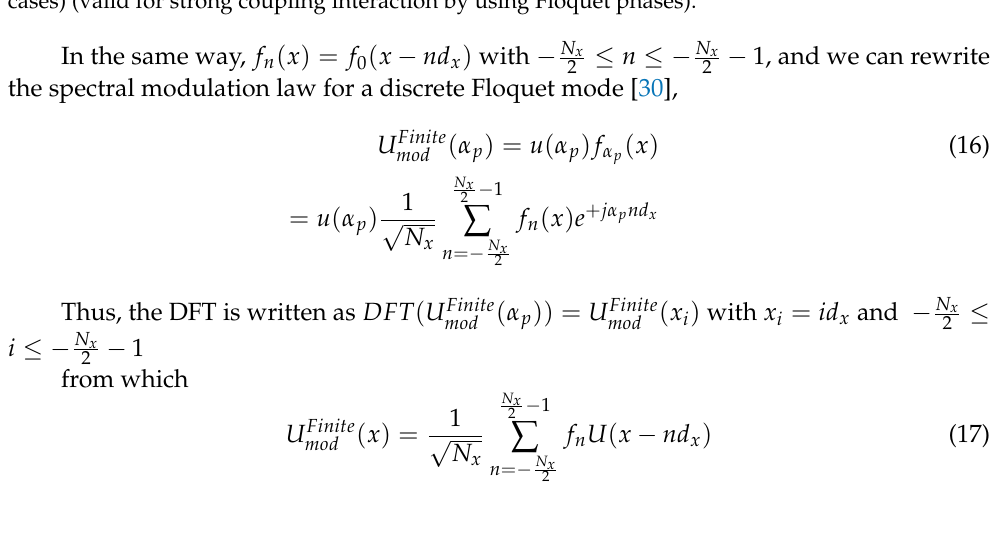
Figure 2. Spectral representation of the interactions of a unit cell with its neighbors (infinite and finite cases) (valid for strong coupling interaction by using Floquet